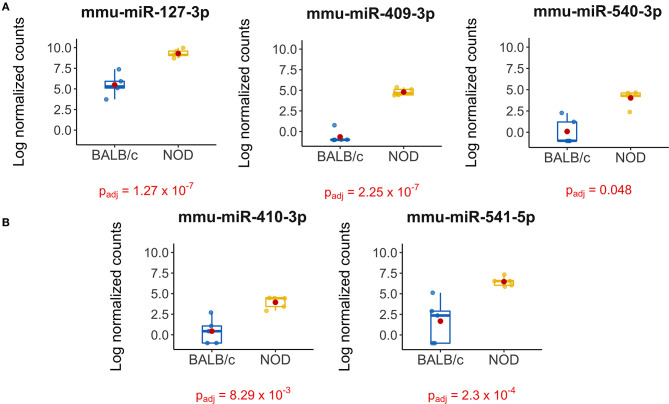
Boxplots of differentially expressed miRNAs in exosomes isolated from 14-week male BALB/c and NOD mouse serum. Reads were aligned with Bowtie and an in-house brute force-based aligner, and differential gene expression analysis was conducted using DESEq2, EdgeR, and LimmaVoom in RStudio. (A) Both DESeq2 and LimmaVoom identified miR-127-3p, miR-409-3p, and miR-540-3p as “hits” with padj < 0.05. (B) Additionally, LimmaVoom identified miR-410-3p and miR-541-5p to be dysregulated with padj < 0.05. miR-329-5p failed to reach statistical significance due to one outlier but exhibited the highest fold change with Log2FC > 5 in EdgeR and DESEq2. Results were obtained from data sets generated from small RNA sequencing of 5 sets of RNA from exosomes from each mouse cohort, each isolated from purified pooled serum exosomes from five groups of age-, gender-, and strain-matched mice, with 5 mice per group.